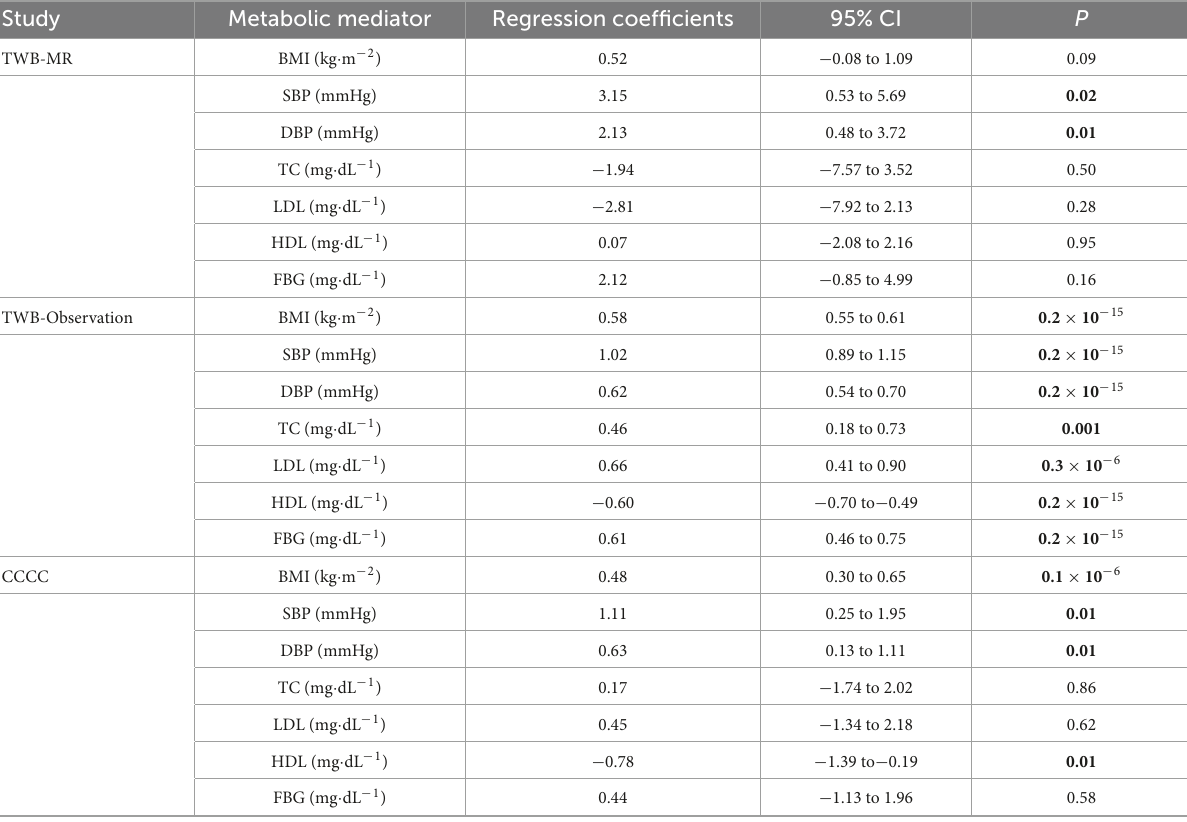
TABLE 3 Effects of one standard deviation earlier age at menarche on metabolic